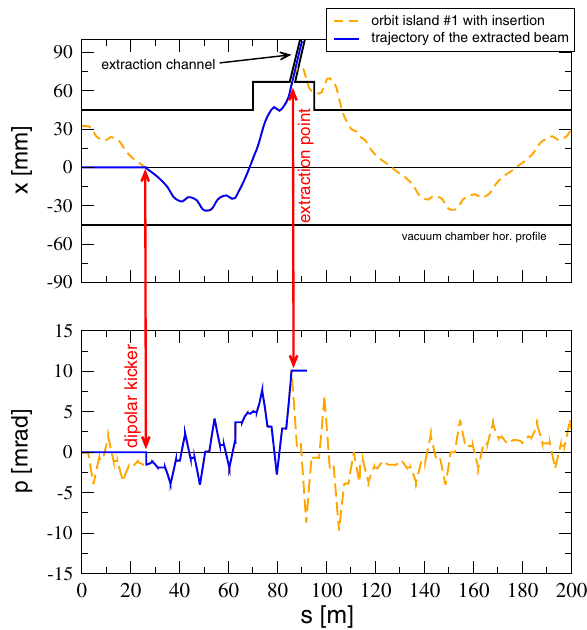
FIG. 5. Example of the beam trajectory (blue) during the last turn of an STE. At a horizontal waist the central beam is displaced onto a fixed point with x (cid:2) ¼ 0 and p (cid:2) x < 0 by a dipolar kicker. This point and the beam trapped in the corresponding island follow an orbit that matches the extraction conditions without having to use a septum to impart the necessary deflection. This example is based on the four-island MTE of the CERN PS: the orbits of the other 3 islands (already shown in Fig. 4) are not displayed as they are not populated.